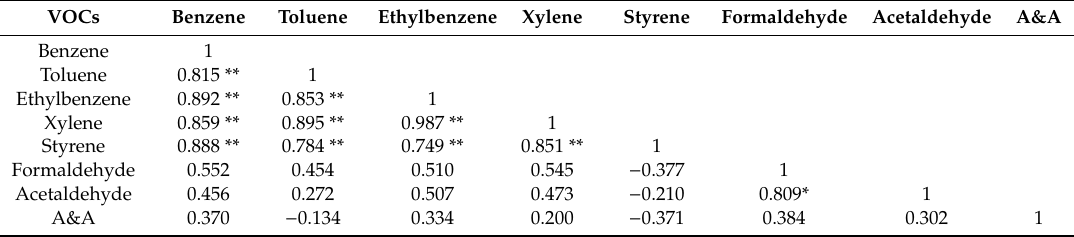
Table 4. Correlation coe ffi cients of volatile organic compounds (VOCs) measured in metro carriages in Shanghai. VOCs Benzene Toluene Ethylbenzene Xylene Styrene Formaldehyde Acetaldehyde A&A Benzene 1 Toluene 0.815 ** 1 Ethylbenzene 0.892 ** 0.853 ** 1 Xylene 0.859 ** 0.895 ** 0.987 ** 1 Styrene 0.888 ** 0.784 ** 0.851 ** 0.334 0.200 − 0.371 0.384 0.302